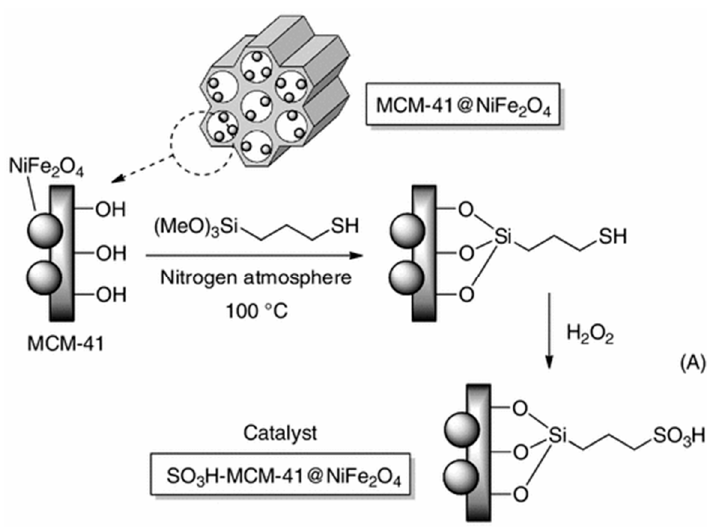
Figure 59. Synthesis of SO 3 H-MCM-41@NiFe 2 O 4 by grafting and oxidation of MCM-41@NiFe 2 O 4 . Reproduced with permission from [155]. Copyright 2014 Springer.